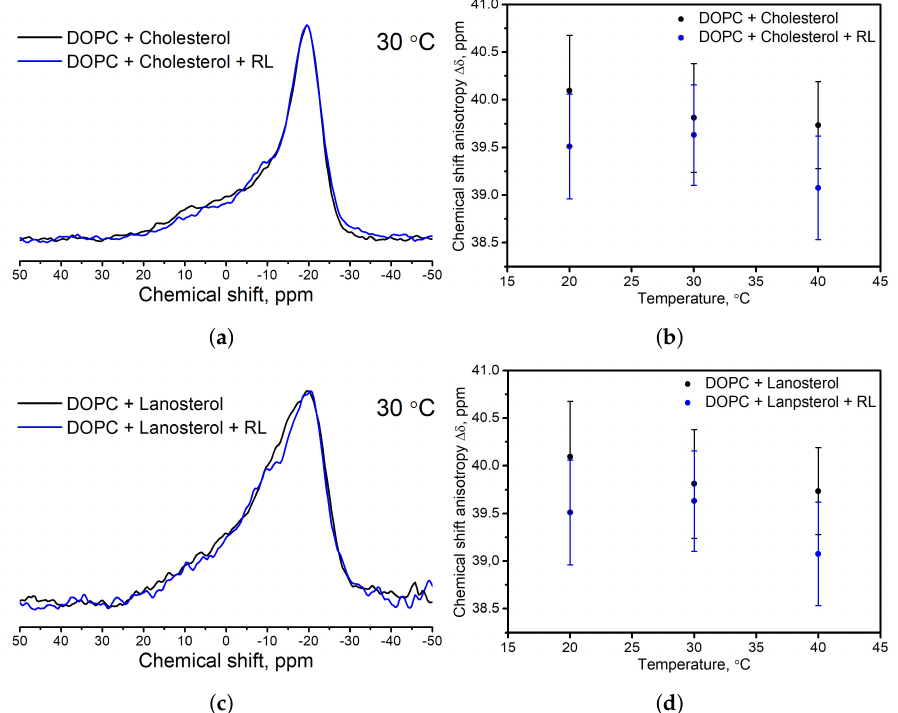
Figure 7. 31 P NMR spectra of liposomes based on DOPC (black solid line), liposomes based on DOPC and injected with rhamnolipids (blue solid line) containing cholesterol ( a ) and lanosterol ( c ). Dependences of CSA ∆ δ values on temperature for samples with cholesterol ( b ) and lanosterol ( d